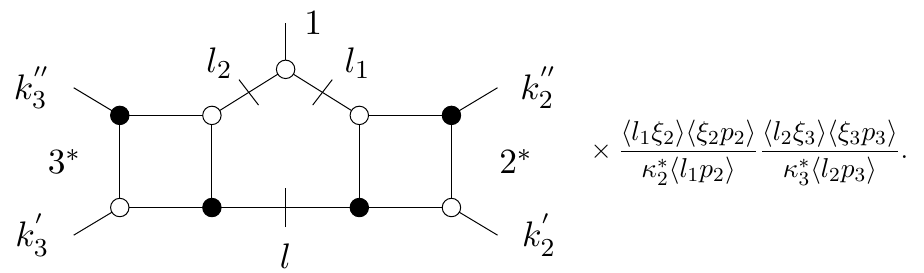
Figure 9 . Regulated on-shell diagram for A (cid:3)